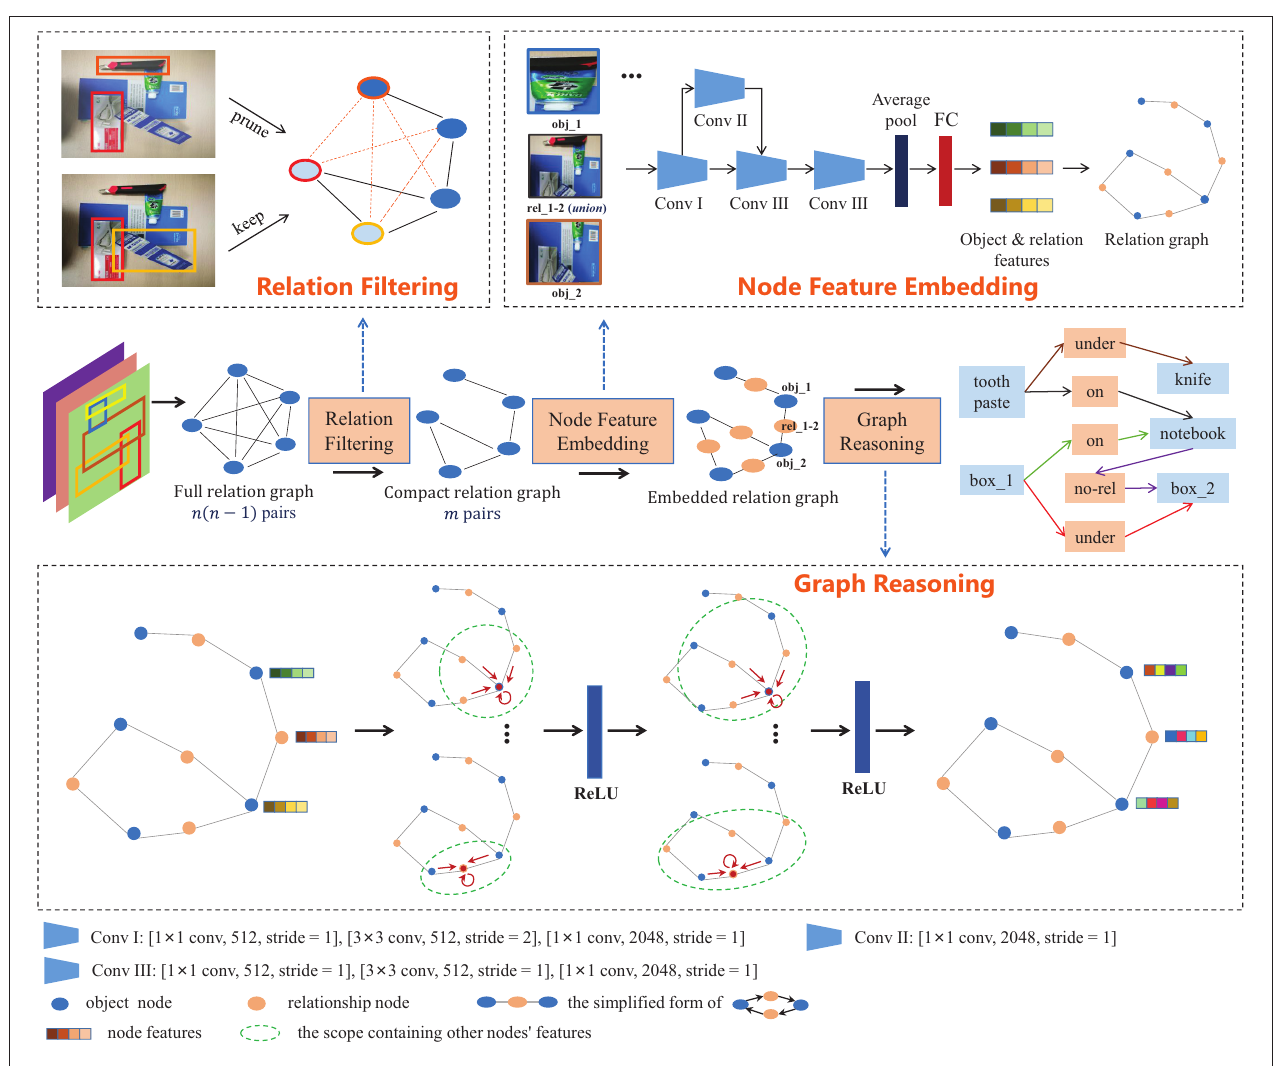
FIGURE 3 | Graph-based relationship reasoning module. It includes three parts: relation filtering, node feature embedding and graph reasoning. Relation filtering reduces the number of object pairs with possible relationships from n ( n − 1) to m . Node feature embedding is used to generate node features and form the embedded relation graph. Graph reasoning is used to update node features and predict object relationships.